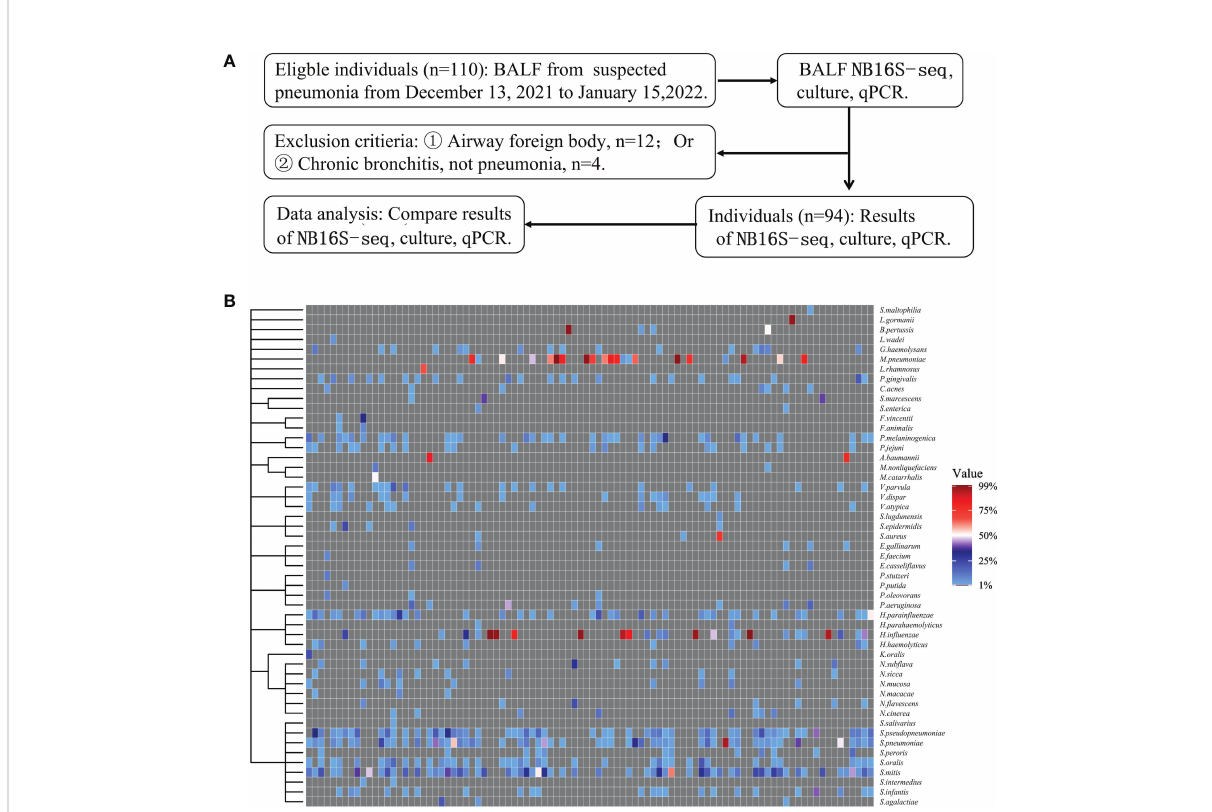
FIGURE 2 Evaluation of NB16S-seq in the etiological diagnosis of pediatric pneumonia (A) : BALF form pediatric pneumonia tested with NB16S-seq, culture or qPCR in our hospital between November 2021 and January 2022. (B) . Heatmap of bacteria abundance ≥ 1.0% in 94 BALF samples tested by NB16S-seq. Each column in the (C) indicates a sample. Formula of abundance = (number of sequences for a species/total number of sequences in the specimen) ×100%. The value indicates abundance, and different colors of the value bar represent the different NB16S-seq